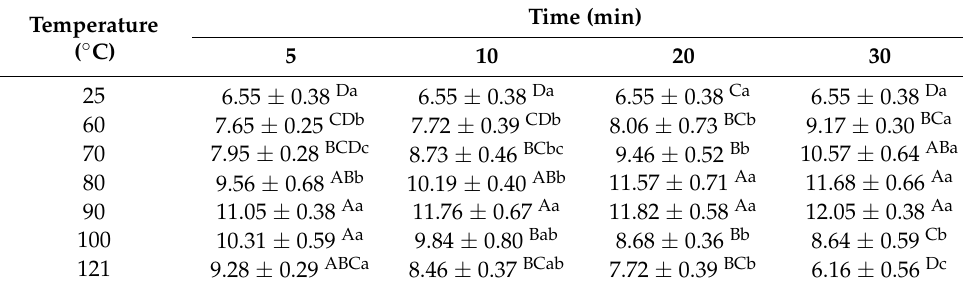
Table 3. Effects of different hydrothermal treatment conditions on the emulsifying activity, m 2 · g − 1 . A– D indicates the significant differences between different temperatures and a–c indicates the significant differences between different times ( p <